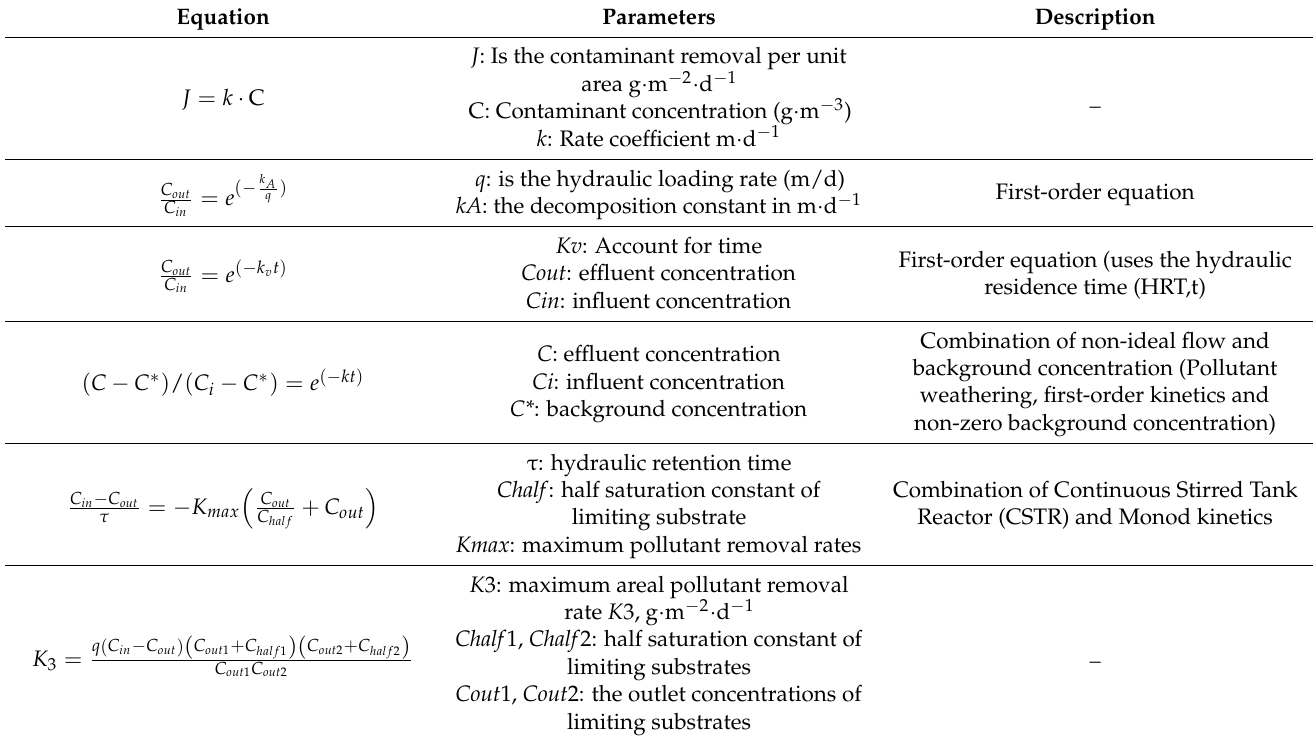
Table 5. Kinetics equations that are used in